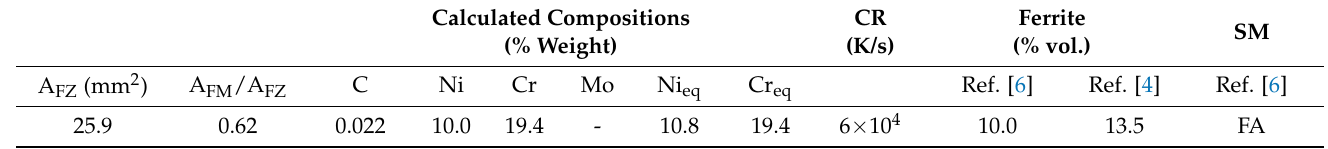
Table 4. FZ composition, cooling rate, ferrite volume (hypothesizing AWS 308L